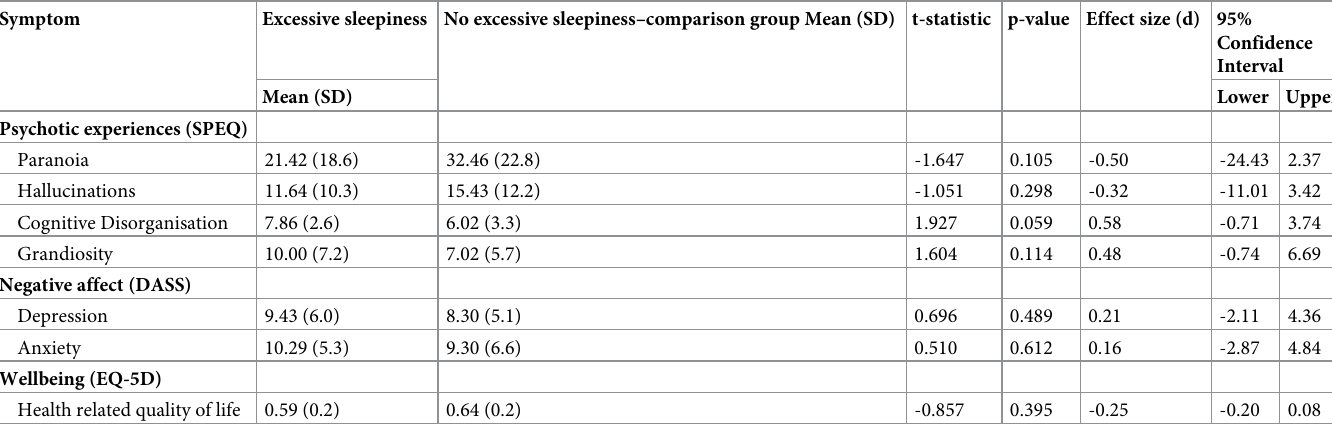
Table 4. Symptom differences between the excessive sleepiness and comparison group.